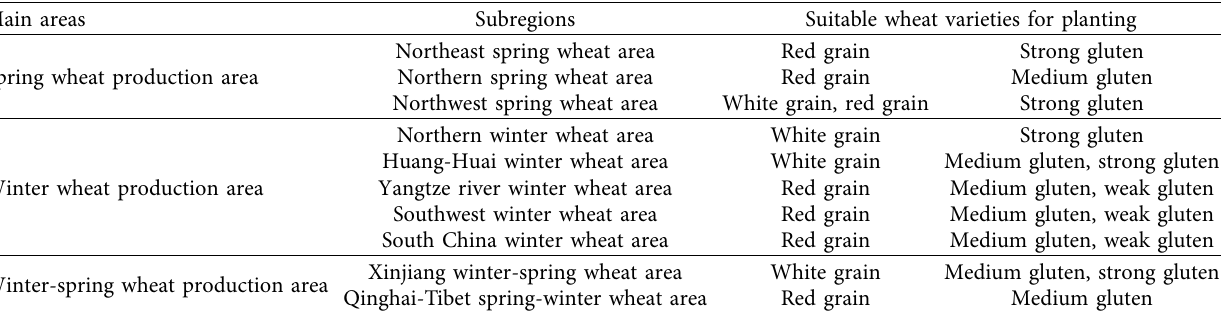
Table 1: Wheat planting regionalization in China.